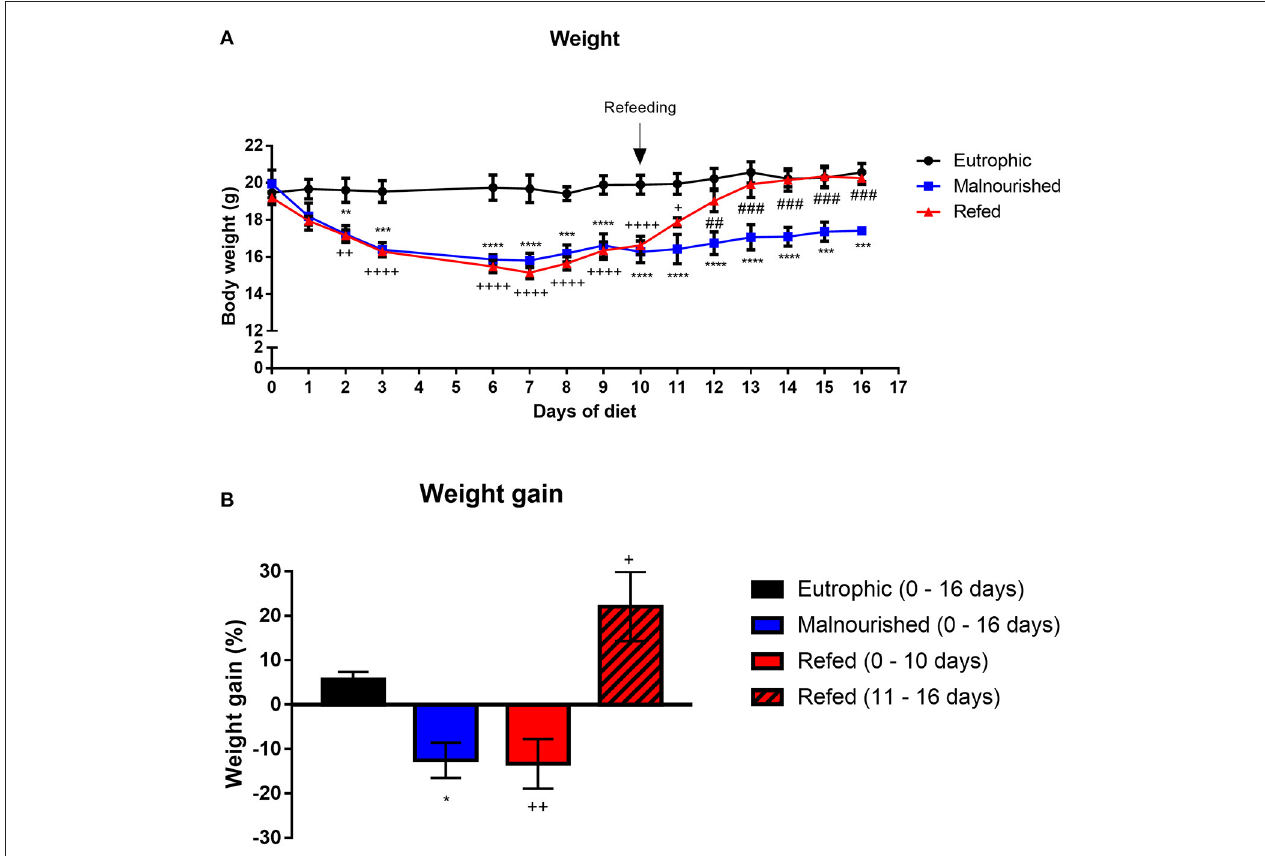
FIGURE 2 | Evaluation of the weight of mice submitted or not to experimental malnutrition and refeeding. Body weight (A) . Percentage of weight gained at the end of the experiment (B) . At the end of the experiment (day 16), the weight gain percentage was analyzed by dividing the final weight (day 16) by the initial weight (day 0) of the mice. In contrast, for the refed mice, the weight on the last day before refeeding (day 10) was divided by the initial weight (day 0), and the weight immediately before refeeding (day 11) was divided by the final weight (day 16). Black: control group; blue: malnourished group; red: refed group between days 0 and 10; striped red: refed group between days 11 and 16. * p ≤ 0.05; ** p ≤ 0.005; *** p ≤ 0.0005; **** p < 0.0001; ## p ≤ 0.005; ### p ≤ 0.0005; ++ p ≤ 0.005; ++++ p ≤ 0.0001. (*) Malnourished vs. control; ( + ) refed vs. control; (#) refed vs. malnourished. The values are represented by the mean ± standard error of three independent experiments with 15 animals per